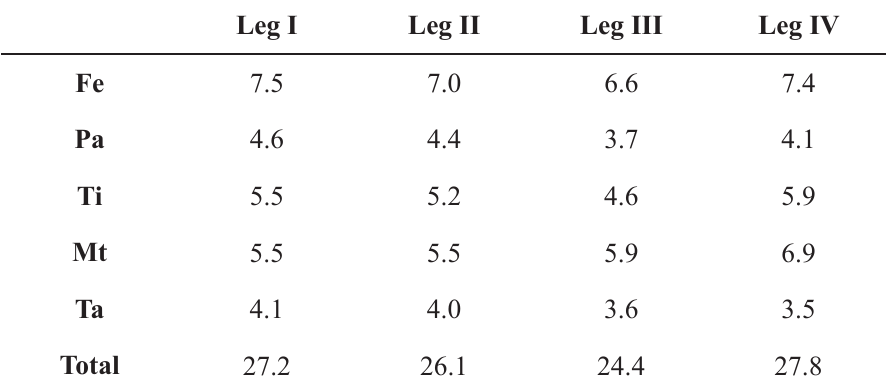
Table 4. Diplura lineata (Lucas, 1857), ♀. Length of left leg articles (dorsal